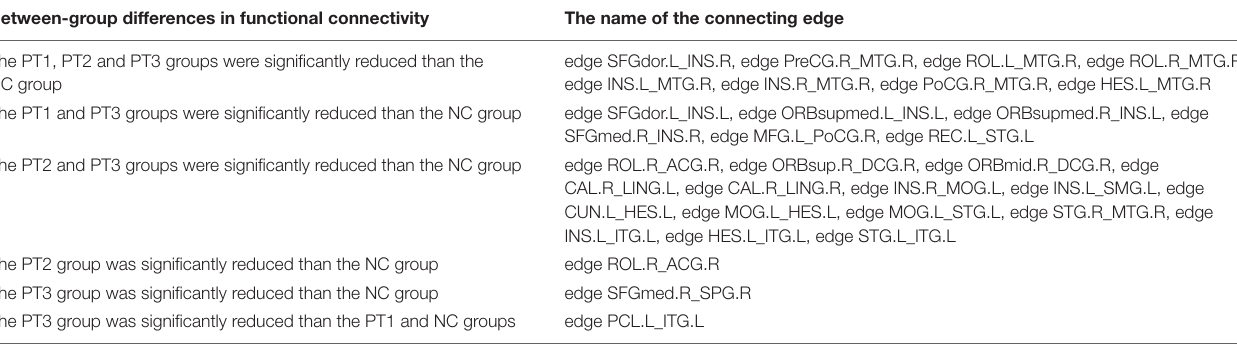
TABLE 2 | Regions with altered functional connectivity in NPC patient groups after RT by NBS analysis. Between-group differences in functional connectivity The name of the connecting edge